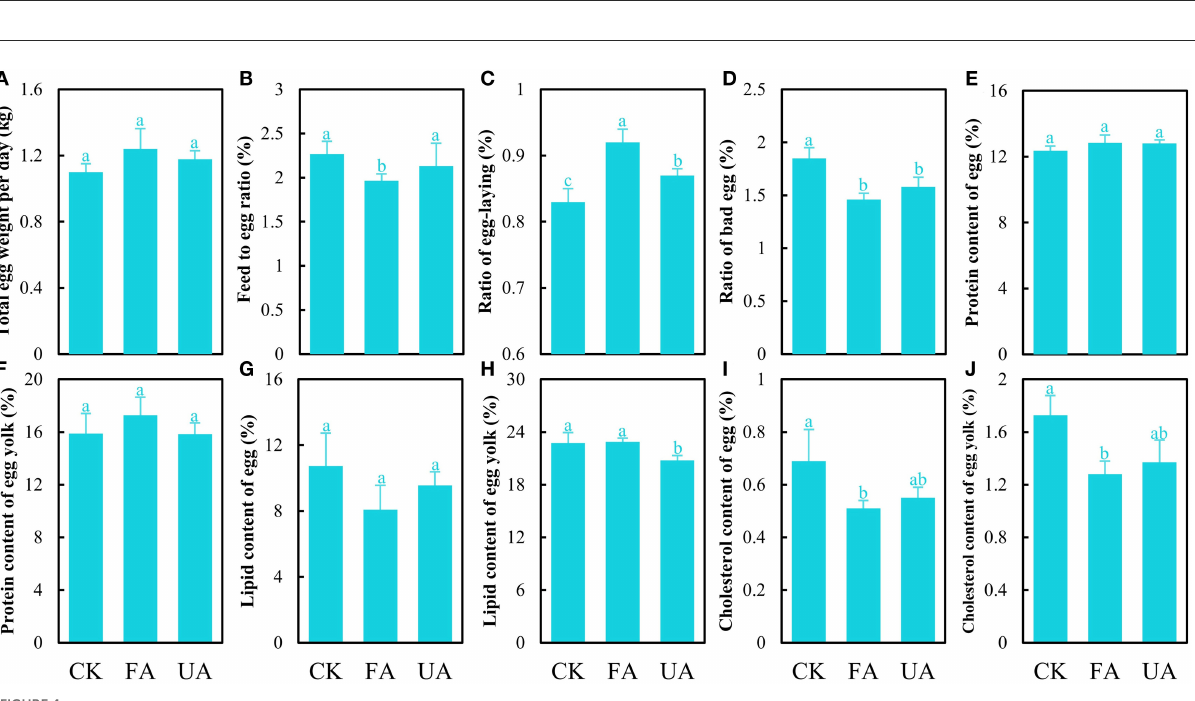
FIGURE4 Performance and egg quality of laying hens after feeding experiments, including total egg weight per day (A) , feed-to-egg ratio (B) , ratio of egg-laying (C) , the ratio of bad egg (D) , protein of egg (E) , protein of egg yolk (F) , lipid of egg (G) , lipid of egg yolk (H) , cholesterol of egg (I) , and cholesterol of egg yolk (J) (one-way ANOVA was performed to evaluate the difference). The same letter showed no significant difference between the chosen groups, while the different letters revealed that significant difference existed between the chosen